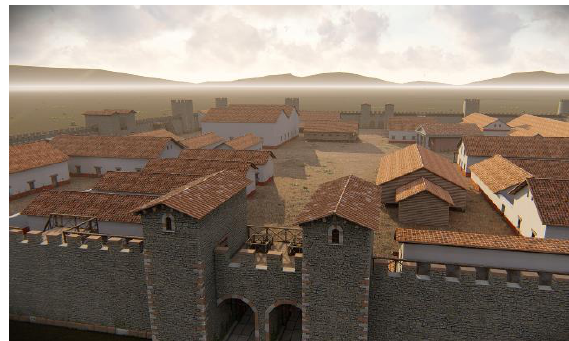
Figure 9a : Model of castellum ( SketchUp )